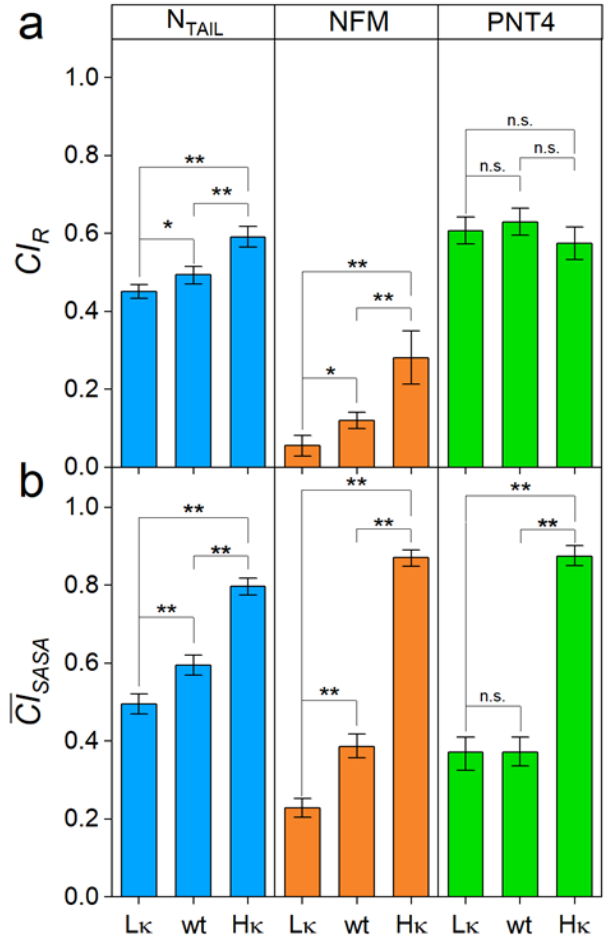
Figure 3. Compactness of the model IDPs. ( a ) CI derived from the R h ( CI R ); ( b ) CI derived from the average SASA of the conformational ensemble ( CI SASA ) of N TAIL , NFM and PNT4 variants (L κ : low- κ ; wt: wild type; H κ : high- κ ). Mean values of three independent measurements are shown with error bars indicating standard deviations. Statistical analyses were carried out using Welch’s t -test, n.s.: not significant p > 0.05, *: p < 0.05, **: p < 0.01.